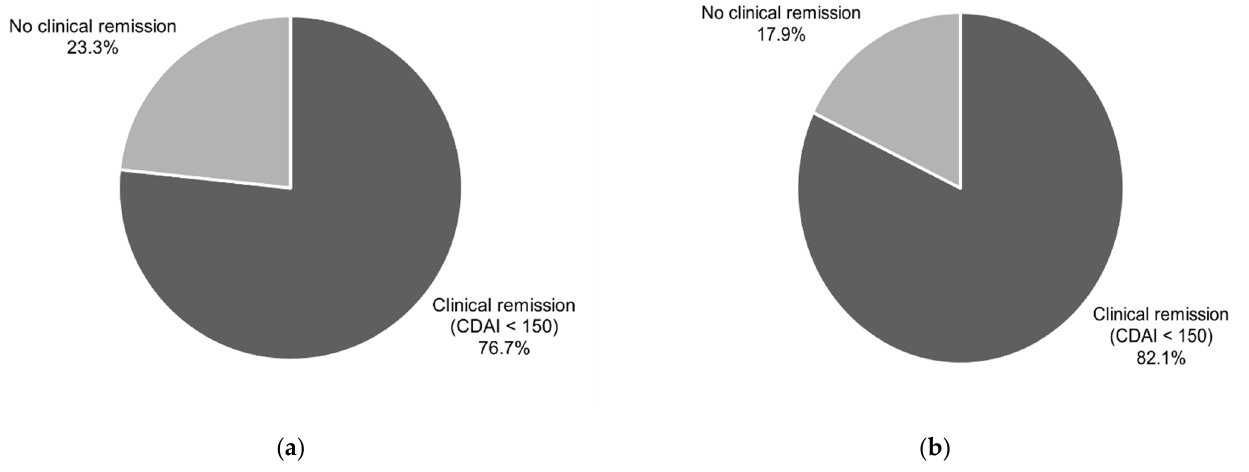
Figure 1. Clinical remission (CDAI < 150) in patients after 6 ( a ) and after 12 ( b ) weeks of CDED.